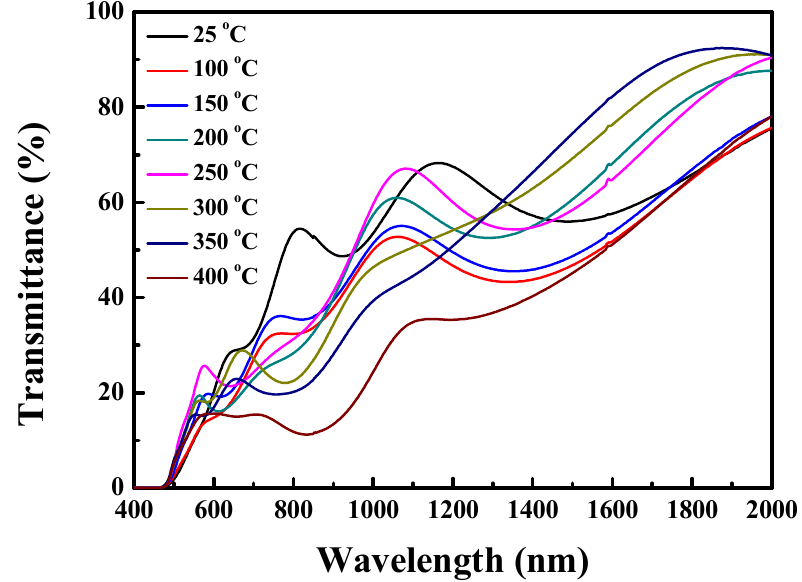
Figure 4. Transmittance spectra of Cu 2 O thin films deposited in the substrate temperature range from 25 °C to 400 °C. Table 3. Average transmittance and optical energy band gap values of Cu 2 O thin films deposited at various substrate temperatures.